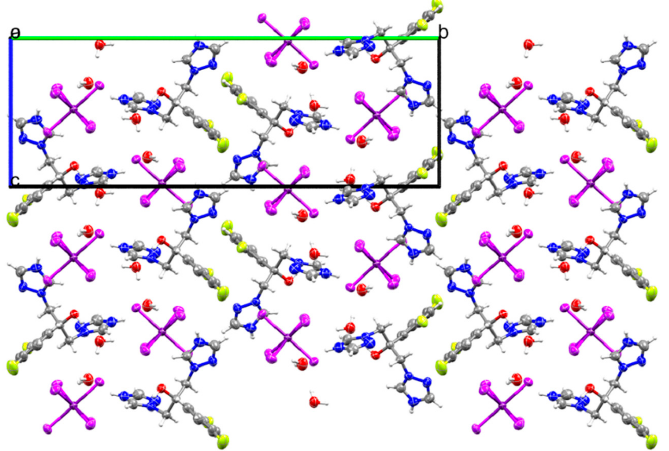
Figure 4. Overall packing of unit cell of (H2Fluconazole).SnCl 6 .2H 2 O viewed along the c-axis.